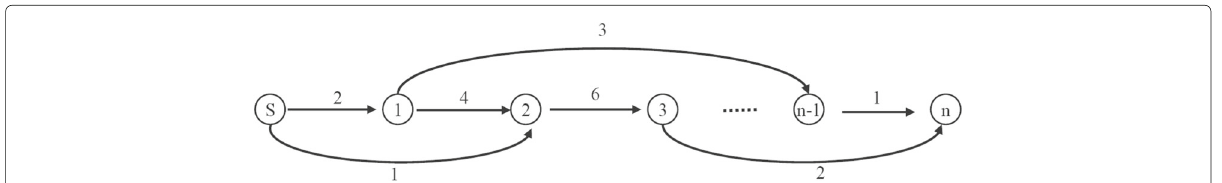
Fig. 1 An example of one dimension directed